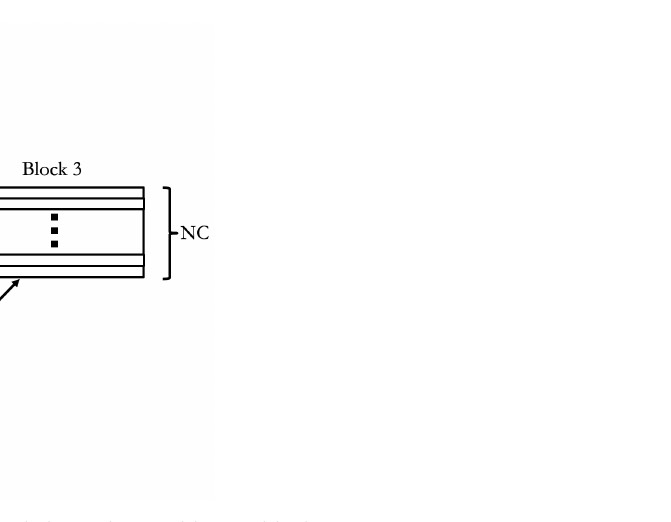
Figure 3. Division of the subchannel assembly into